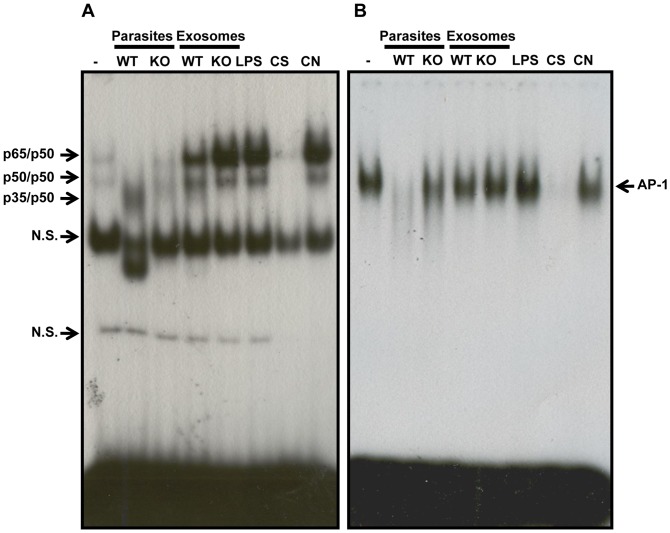
Modulation of TFs by Leishmania parasites and exosomes.EMSAs show that Leishmania infection can result in translocation of a modified form of NF-κB (A) and AP-1 (B) degradation as previously reported. Stimulation with parasite exosomes shows that KO exosomes induce stronger translocation of NF-κB and AP-1 into the nucleus and thus appear more inflammatory compared to WT exosomes. Results are representatives of at least 3 independent experiments. C.S. Specific Competitor, 100× concentration of non-labelled oligo. C.N. Non-Specific competitor, 100× concentration of non-labelled consensus SP-1 oligo. N.S. Non-specific.